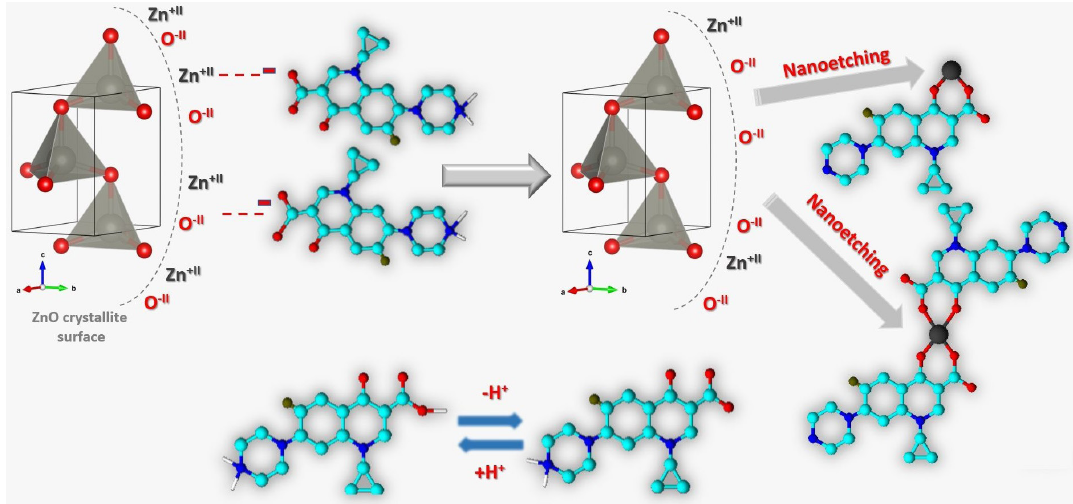
Figure 8. Formation of CIPRO-Zn complexes by nanoetching of ZnO surfaces. ZnO suspension promotes alkalinization of pure water to 7.9 that is above CIPRO pI (7.14). The unprotonated carboxylic group and the carbonyl group and pyridone carbonyl form a bidentate complex with Zn 2+ that can coordinate with another CIPRO molecule forming a 2:1 CIPRO-Zn